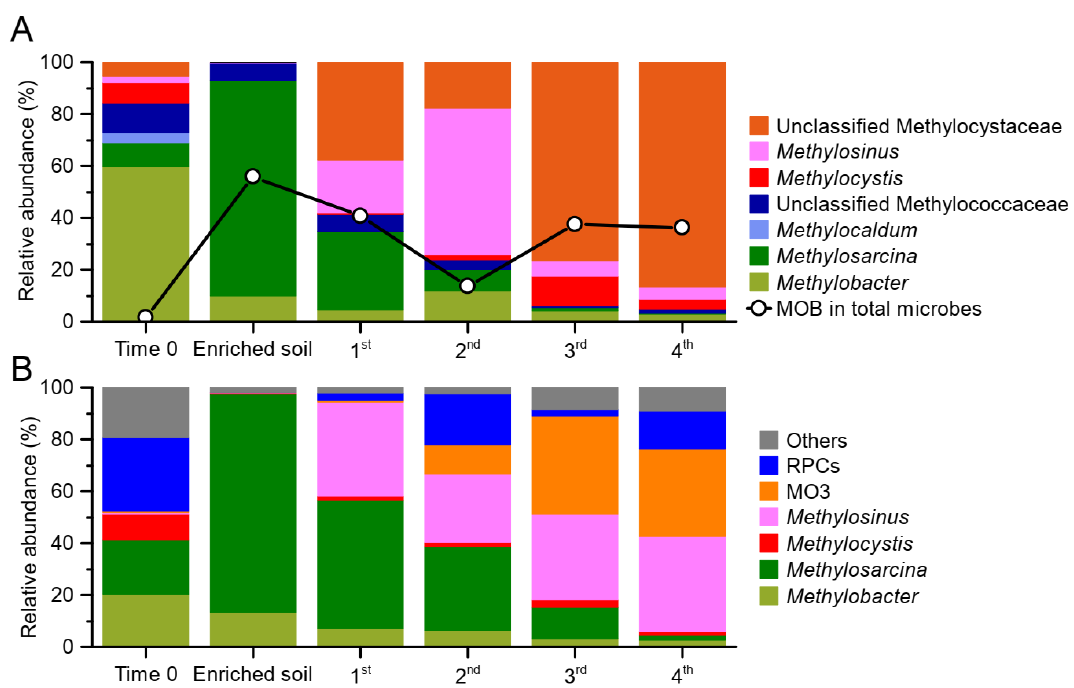
Figure 1. Changes in methanotrophic community compositions during enrichment in soil and nitrogen-free M2 medium. ( A ) Relative abundance of methanotrophs in total microorganisms and their community composition based on amplicon sequencing of partial 16S rRNA gene. ( B ) Changes in methanotrophic community composition based on amplicon sequencing of partial pmoA gene. 1st, 2nd, 3rd, and 4th mean the enrichment round in nitrogen-free M2 medium.